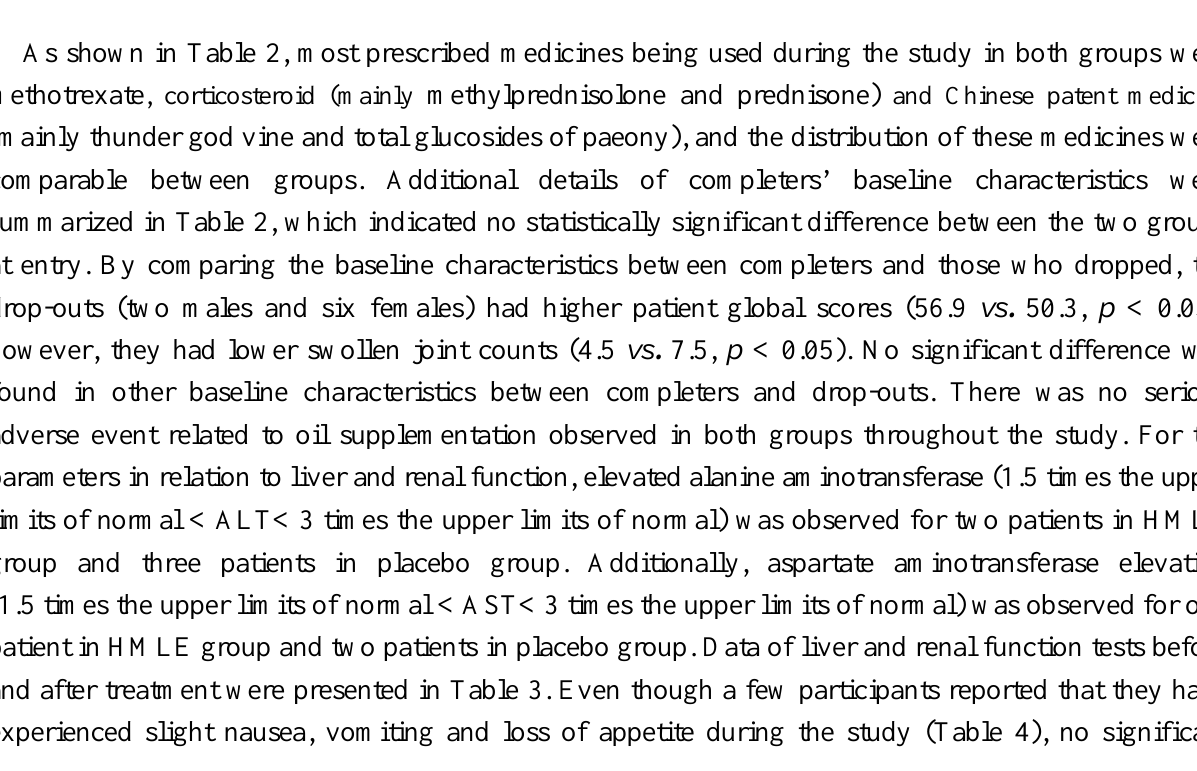
Figure 1. Flowchart of patient disposition over 6